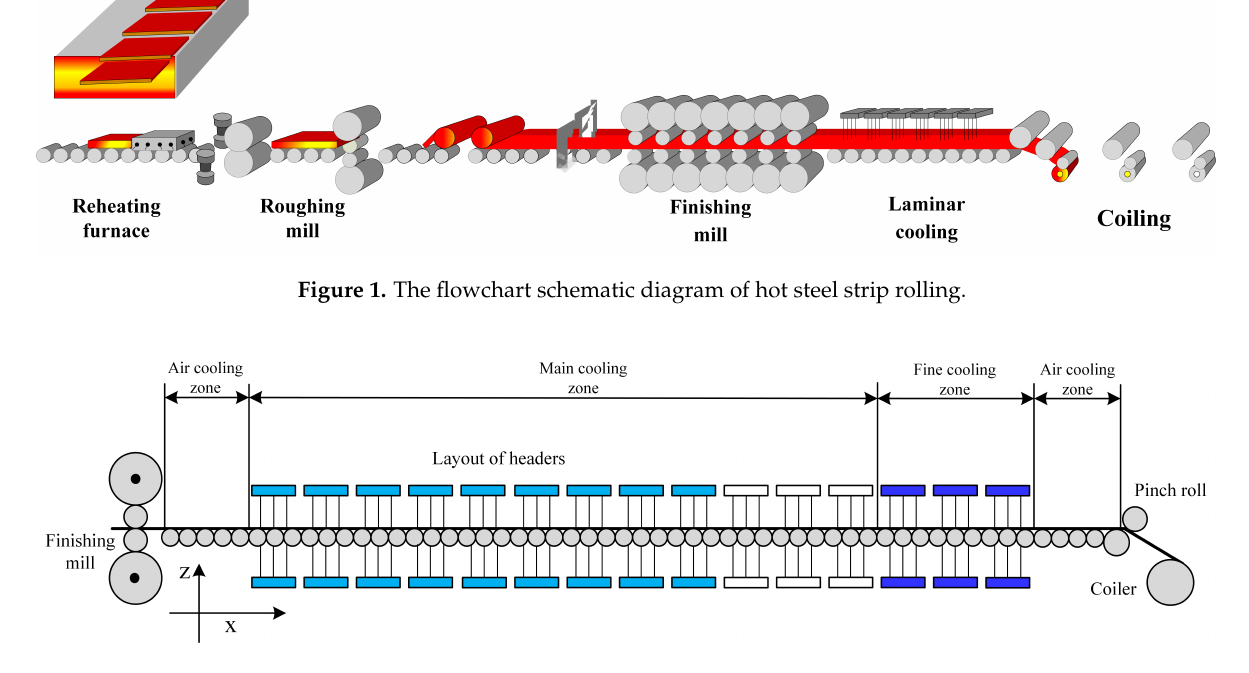
Figure 2. The schematic diagram of laminar cooling